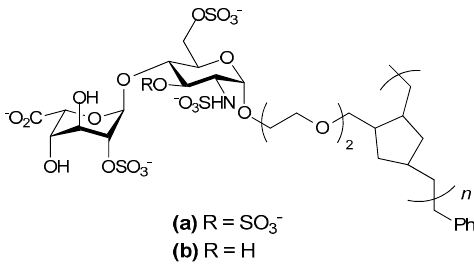
Figure 4. Chemical structure of tailored glycopolymers as anticoagulant heparin mimetics.